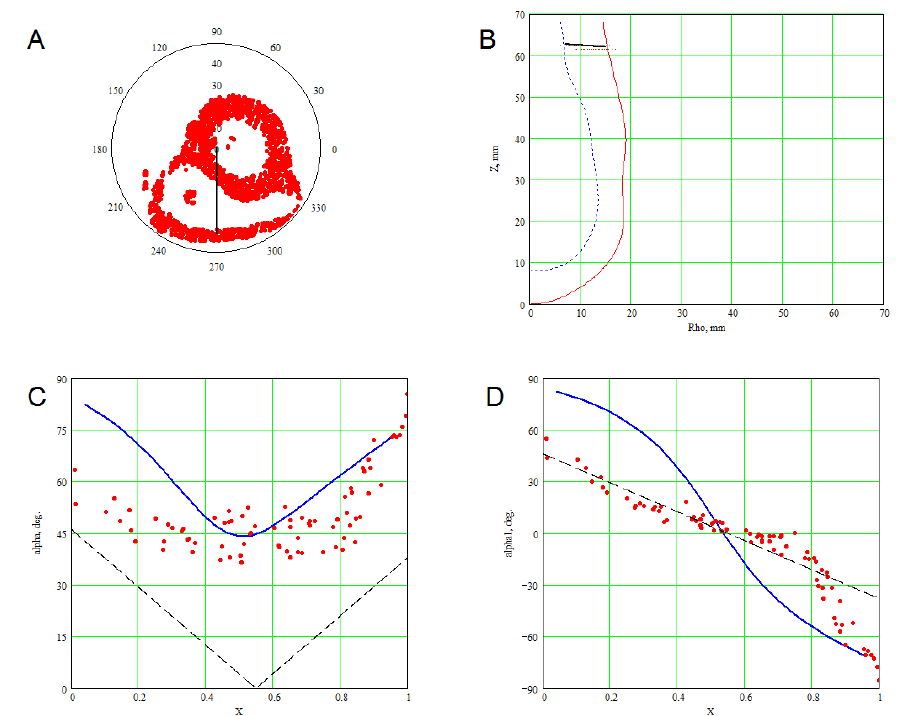
Figure 10. Fiber angles in the model and experimental data. The IVS in the basal area ( ψ = 5 ◦ ) is shown. The conventional signs are the same as in Figure 7.